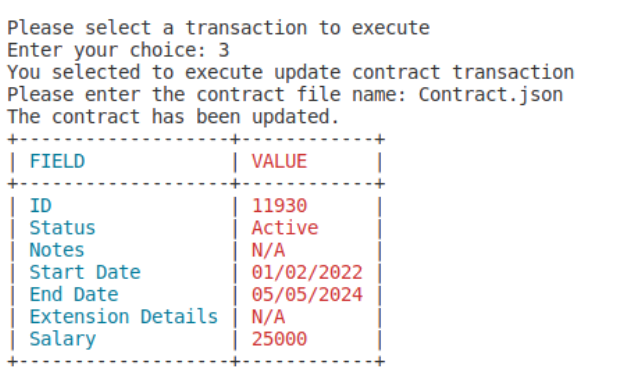
Figure 7. An employer peer issues “UpdateContract”, increasing the salary of her/his employee.